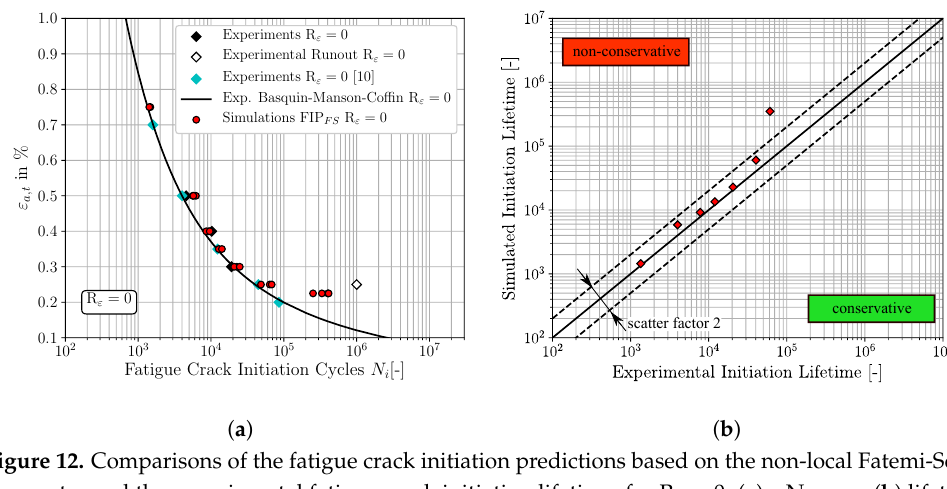
Figure 12. Comparisons of the fatigue crack initiation predictions based on the non-local Fatemi-Socie parameter and the experimental fatigue crack initiation lifetime, for R ε = 0: ( a ) ε -N-curve ( b ) lifetime correlation plot.